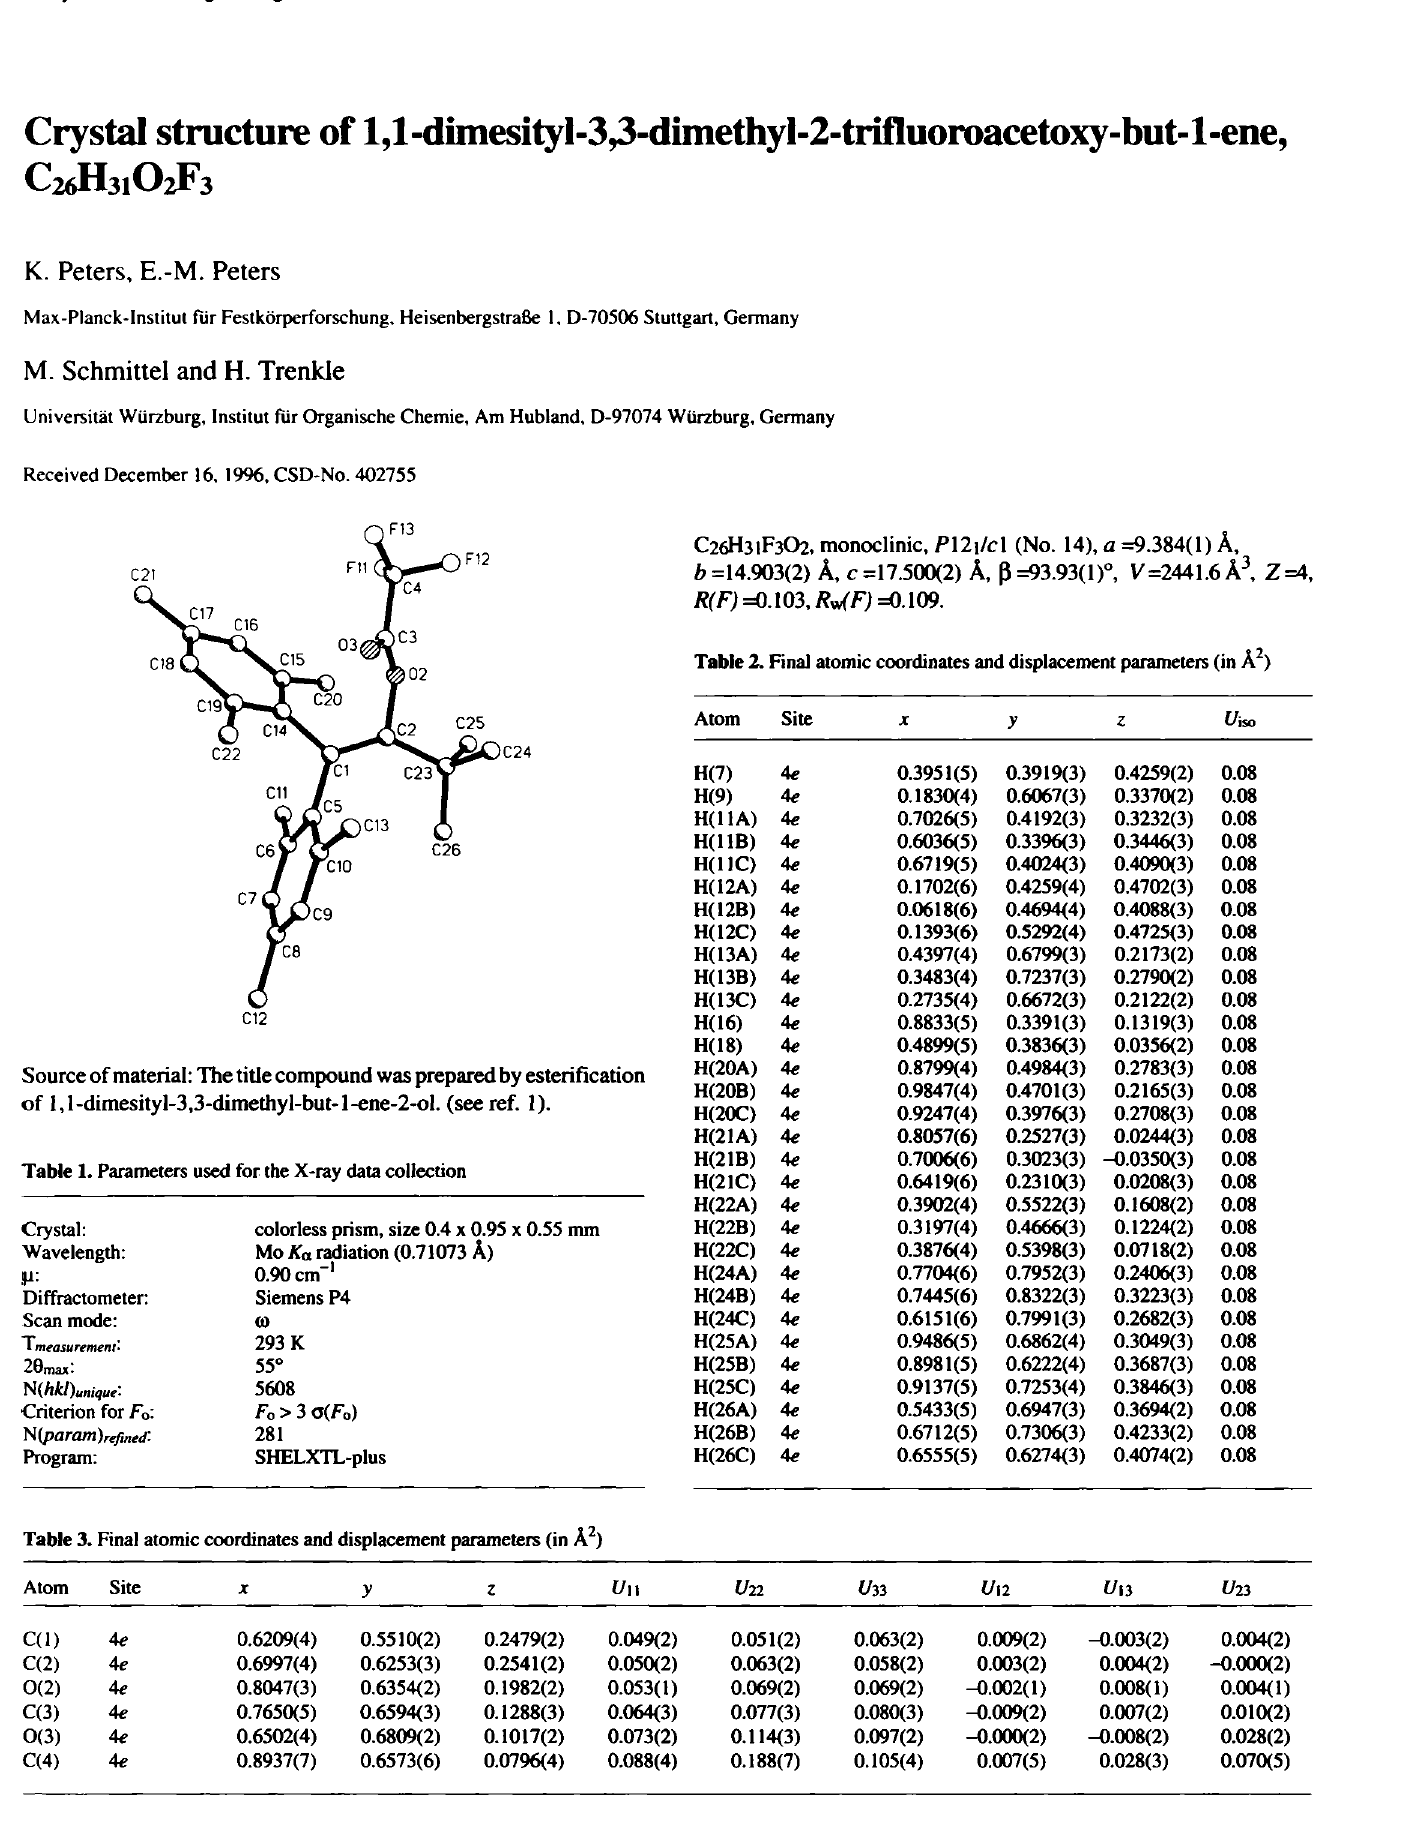
Table 3. Final atomic coordinates and displacement parameters (in Â 2 ) Atom